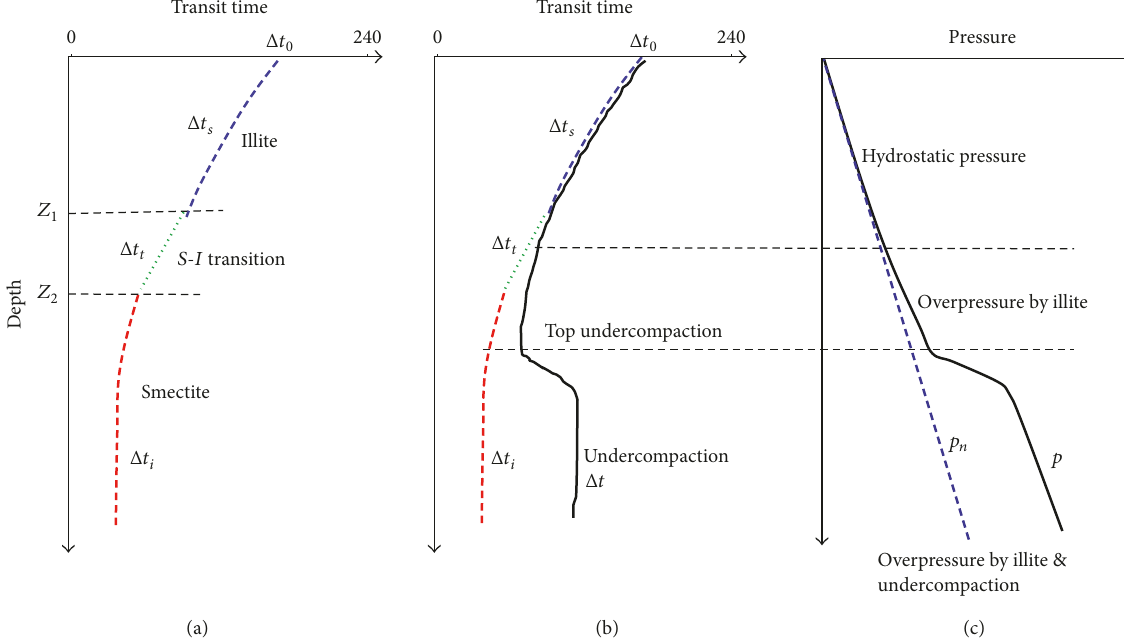
Figure 2: NCTs in the transit time versus the depth for the shale composed of the smectite and illite. (a) Composite NCT; (b) composite NCT and transit time; (c) overpressures caused by smectite to illite conversion and